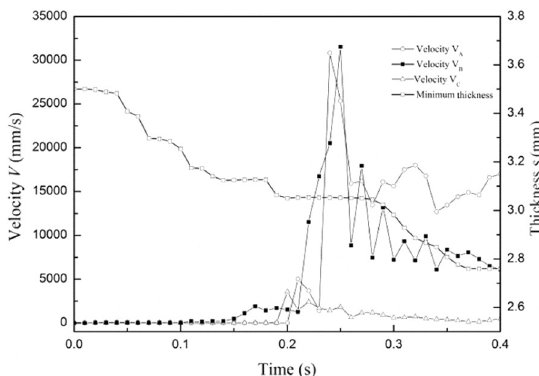
Figure 34 A , B , C three-point velocity and minimum wall thickness